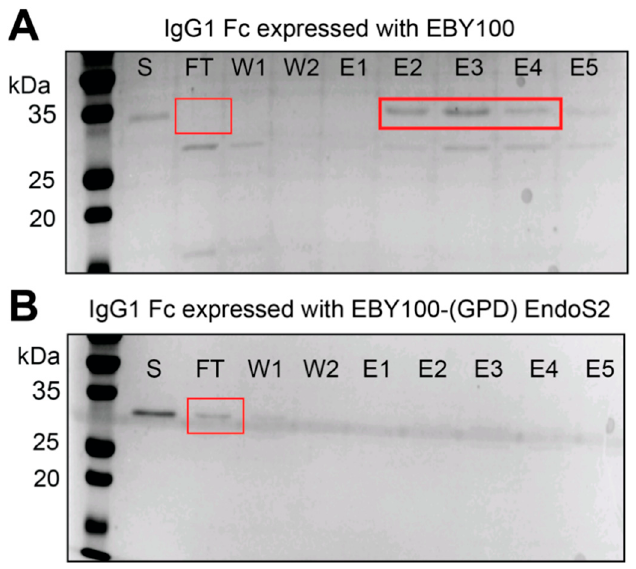
Figure 5. Identification of oligomannose N- glycans on secreted IgG Fc. Concanavalin A